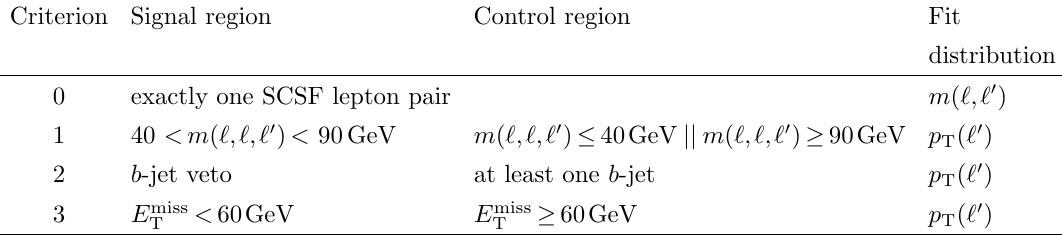
Table 3. Signal and control region selection criteria for the prompt HNL analysis and the corre- sponding distribution used in the binned maximum-likelihood (cid:12)t in the SR (criterion 0) and the three CRs (criteria 1{3). In addition, estimation regions corresponding to the SR and the three CRs are de(cid:12)ned by requiring all leptons to have the same charge. Criteria 0{3 are all used for the SR. Only one of them is inverted to de(cid:12)ne the corresponding